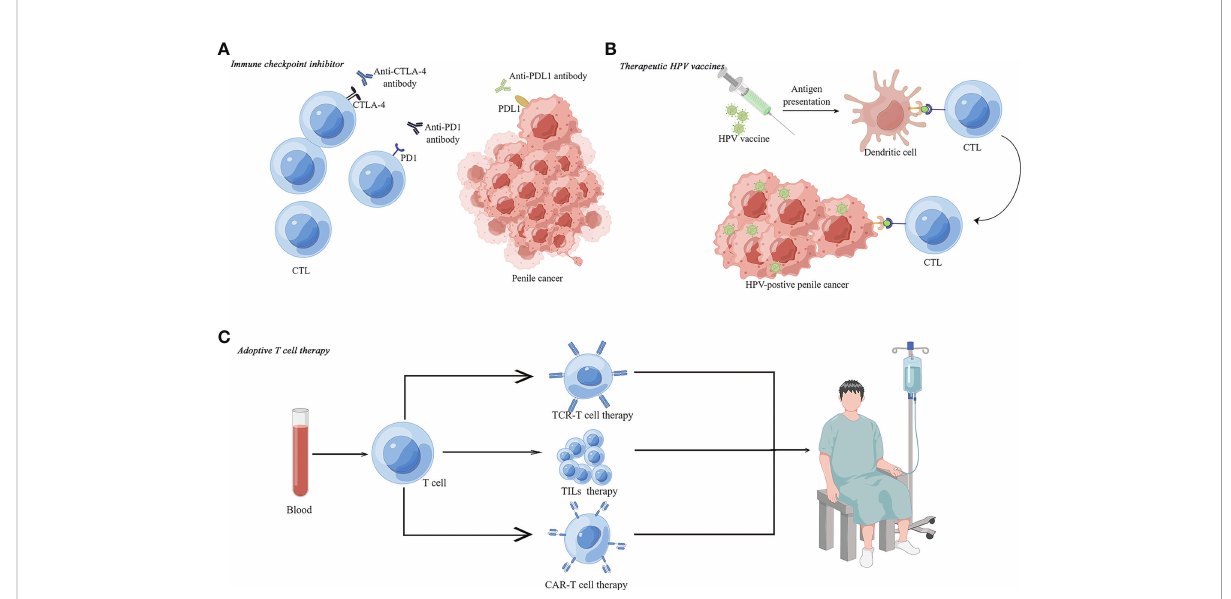
FIGURE 2 Immune-based therapies for penile cancer. (A) Immune checkpoint inhibitors (ICIs) include anti-PDL1, anti-PD1 and anti-CTLA4 agents. (B) Therapeutic HPV vaccine can activate the immune system to kill HPV-positive penile cancer. (C) Adoptive T-cell therapy (ATC) for penile cancer, such as tumor-in fi ltrating lymphocytes (TILs) therapy, chimeric antigen receptor therapy (CAR-T) and T cell receptor (TCR)